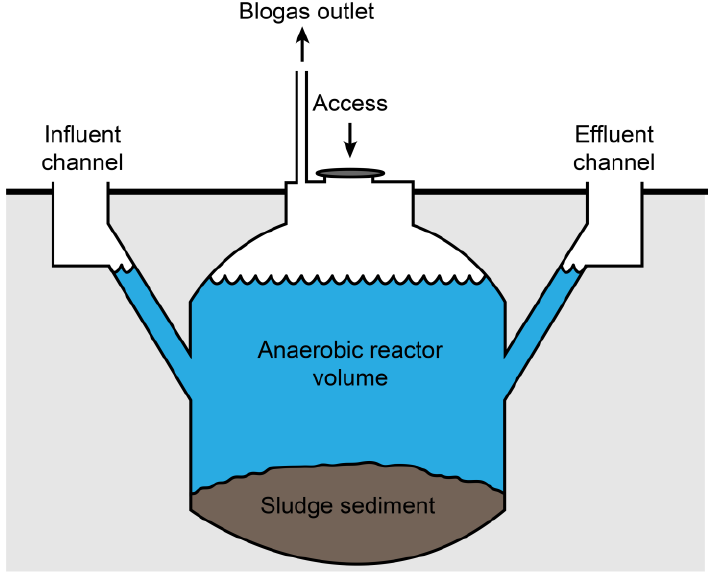
Figure 1. Schematic diagram of the simple unheated biogas digester. The diluted manure water mixture is added manually to the influent channel and digested slurry is removed manually from the effluent channel ( © University of Southern